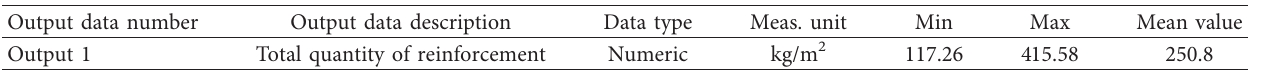
Table 3: Output data of the second model.